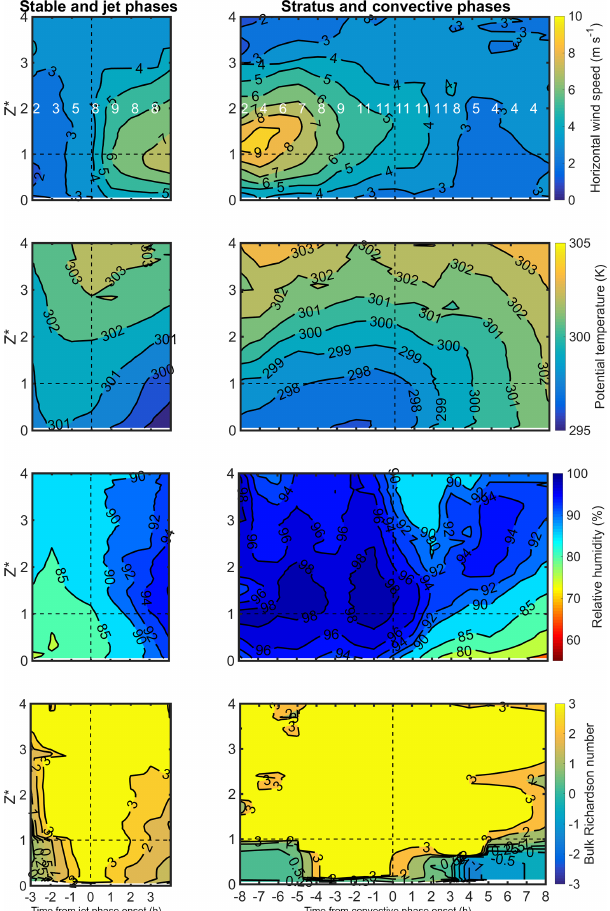
Figure 3. Mean height–time sections for, from top to bottom, hor- izontal wind speed (ms − 1 ), potential temperature (K), relative hu- midity (%), and bulk Richardson number (colour scale and iso- lines). These height–time sections are built by (i) normalizing the height by the CBH when the stratus clouds form for each individ- ual radiosounding, (ii) setting the origin of time with a time ref- erence appropriately chosen according to the considered phase, and (iii) hourly averaging the radiosoundings. The origin of time is set to (left column) MI arrival time (negative and positive times standing for stable and jet phases, respectively) and (right column) start of the convective phase ( H > 10Wm − 2 ) (negative and positive times standing for stratus phase and convective phase, respectively). The horizontal dashed line ( Z ∗ = 1) indicates the CBH when the stratus clouds form. White numbers in the top panels indicate the number of radio soundings available for the hourly average.